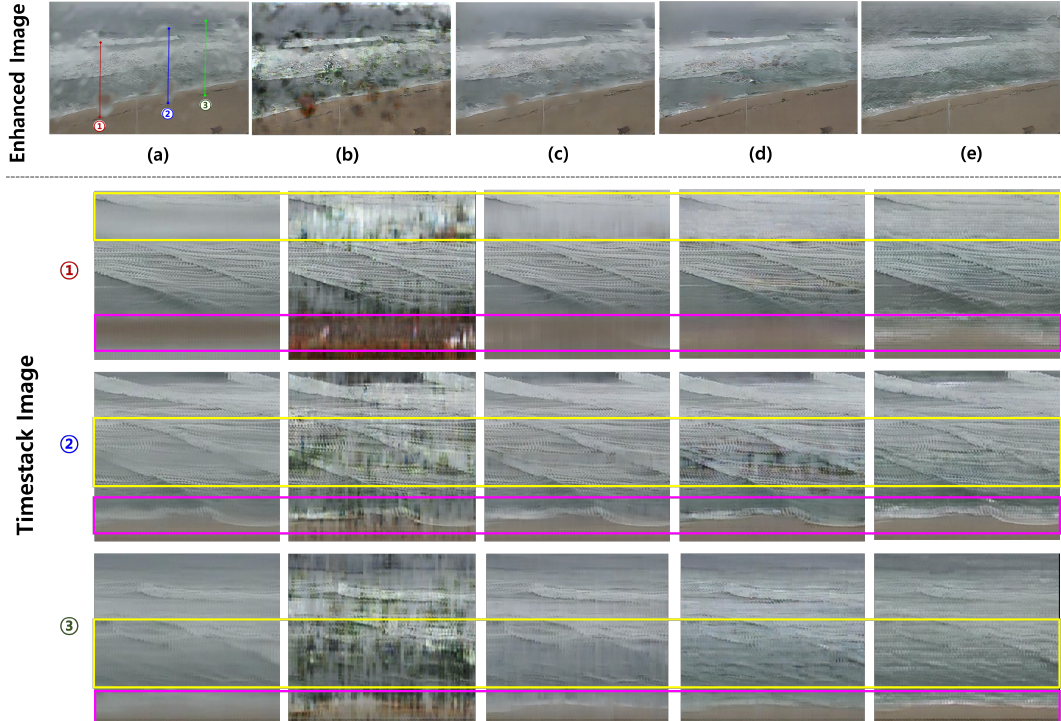
Figure 10. Test examples with time-stack images: The upper part shows the enhanced images of raindrop-contaminated image ( a ) by applying Pix2Pix in ( b ); Attentive GAN in ( c ); pre-trained Raindrop-aware GAN in ( d ); and fine-tuned Raindrop-aware GAN in ( e ). The lower part shows the timestack images acquired at the line transect marked 1 (cid:13) , 2 (cid:13) , and 3 (cid:13) in ( a